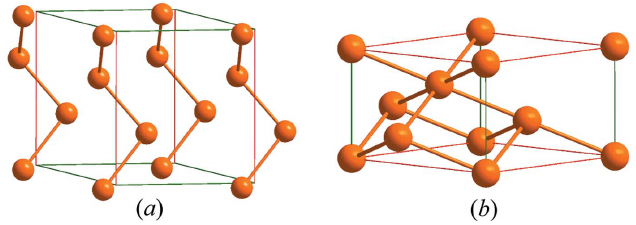
Figure 1 The crystal structures of Se-I ( a ) and Se-V 0 ( b ). Unit-cell edges in the directions that contract with increasing pressure are shown in green, while those in the directions that expand with increasing pressure are shown in